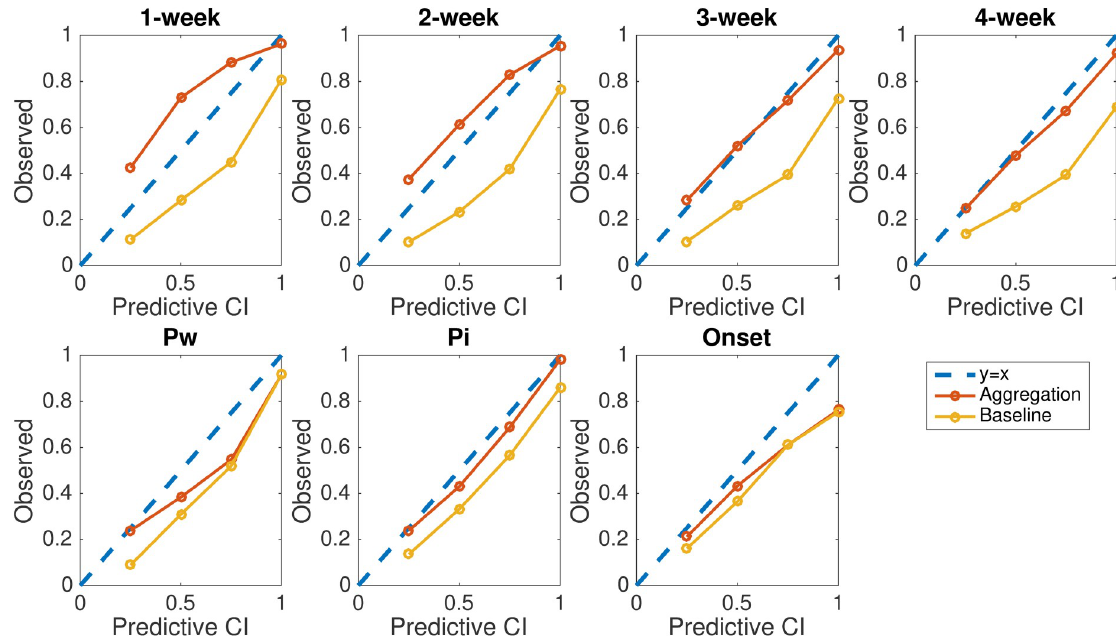
Fig 5. Reliability plots for seven targets of ILI forecast targets. Reliability plots for 1- to 4-week ahead ILI, peak week, peak intensity, and onset week are compared for multi-pathogen and single-pathogen forecasts. Data points show the fraction of observed targets falling within the 25%, 50%, 75% and 100% prediction intervals. Results are obtained from retrospective forecasts during 15 seasons at the US national level and for HHS regions 1 to 9.